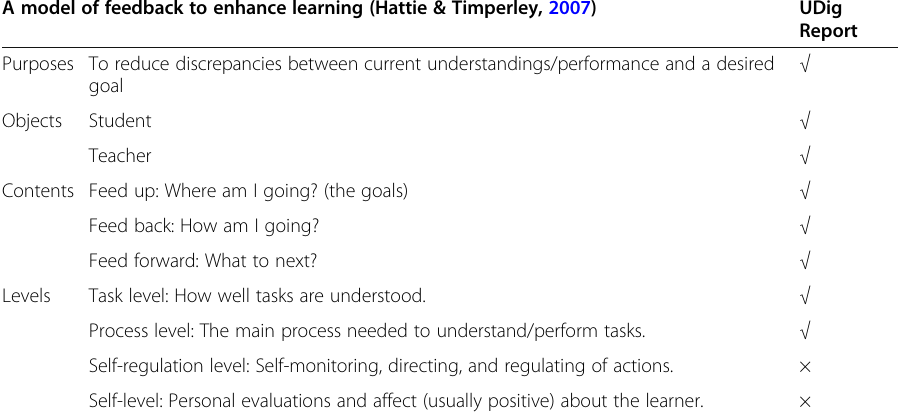
Table 2 Dimensions of UDig diagnostic score reports on reading comprehension (adapted from Fan,